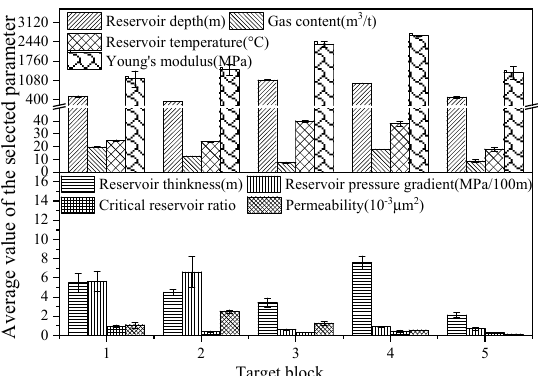
Figure 2. The average value and gray standard deviation histogram of evaluation parameters of 5 target blocks.